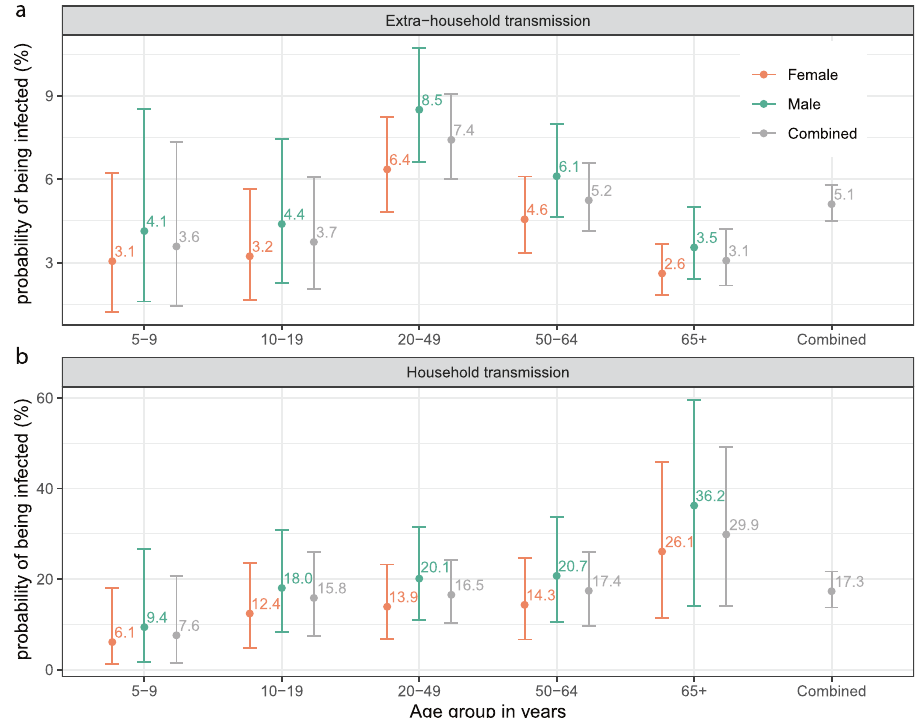
Fig. 2 Risk of extra-household transmission and within-household transmission from a single infected household member. a Estimated median probability of extra-household infection from the start of the epidemic in Geneva until the time of the serosurvey by age group and sex. b Estimated median probability of infection from a single infected household member by age group and sex. Dots and bars represent median and 95% credible intervals of the posterior distribution. Probabilities of being infected by sex and age group of the exposed individuals are estimated by a model only including age and sex of the exposed individuals (model 2, orange/green bars; see Table S2). Probabilities of being infected by the age group of the exposed individuals combining males and females (left four gray bars on both panels) are estimated with an age-only model (model 1). The overall probabilities of being infected (rightmost gray bar on both panels) are estimated with the null model (model